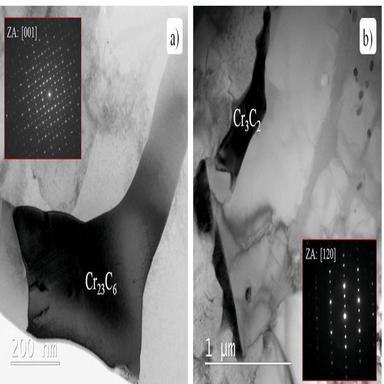
TEM micrographs of a) Cr23C6 carbides along with the SADP (inset) and b) Cr3C2 carbide along with SADP (inset).